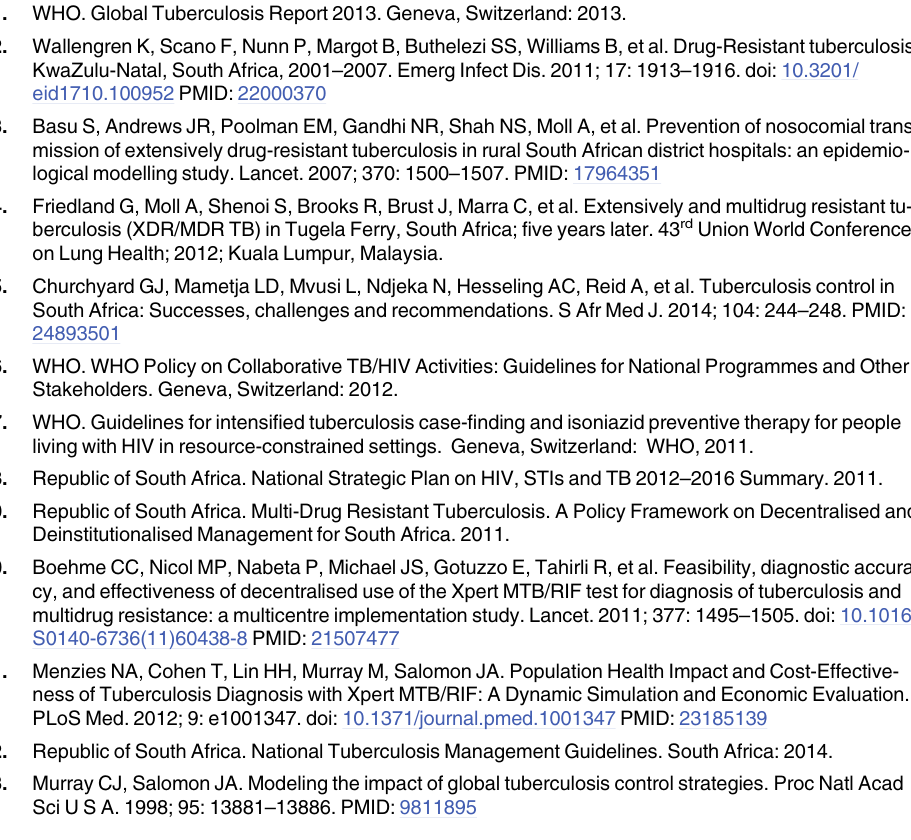
S3 Table. Global Sensitivity Analysis. Partial rank correlation coefficients (PRCCs) and p-val- ues calculated from model outcomes generated from minimum and maximum of parameter distributions found in S1 Table in a global sensitivity analysis of annual CICF